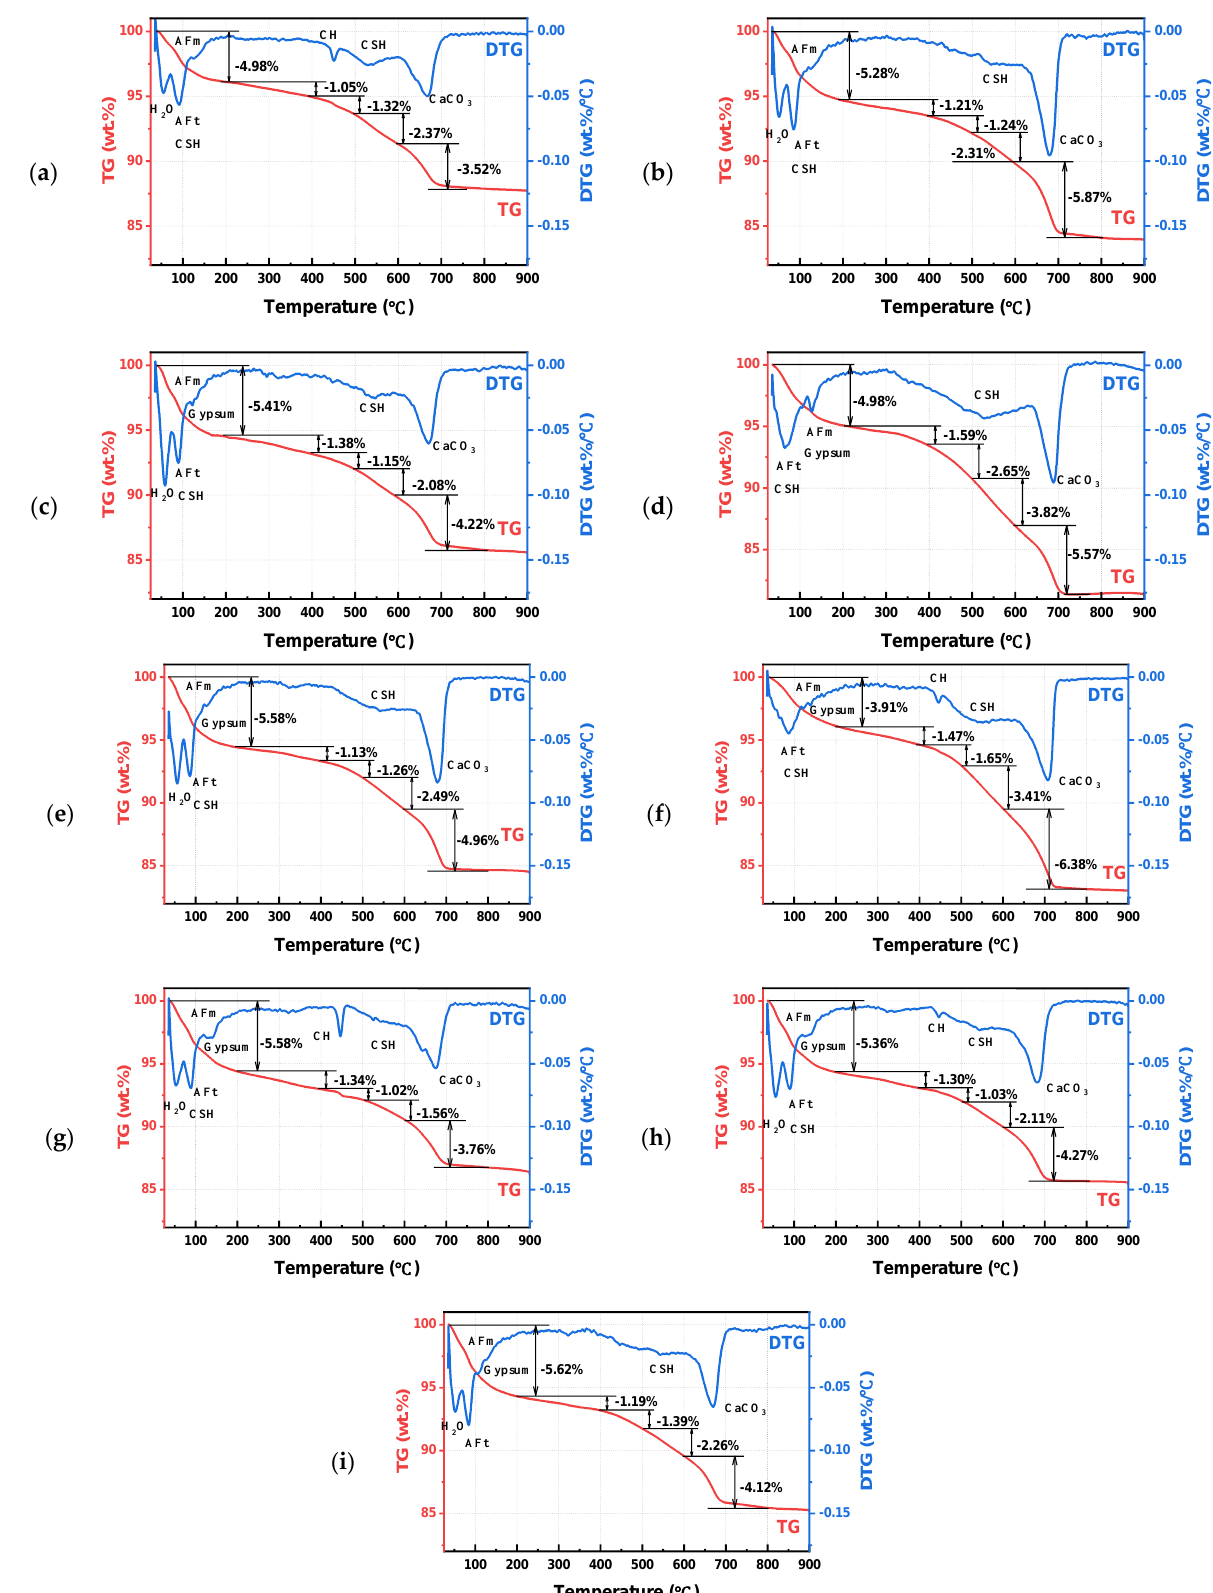
Figure 11. TG and DTG curves of different sulfate-attacked CGC specimens: ( a ) CGCS10-28 d; ( b ) CGCS10-60 d; ( c ) CGC30S10-120 d; ( d ) CGC30S10-240 d; ( e ) CGC20S10-120 d; ( f ) CGC40S10-120 d; ( g ) CGC30S0-120 d; ( h ) CGC30S5-120 d; ( i ) CGC30S15-120 d.